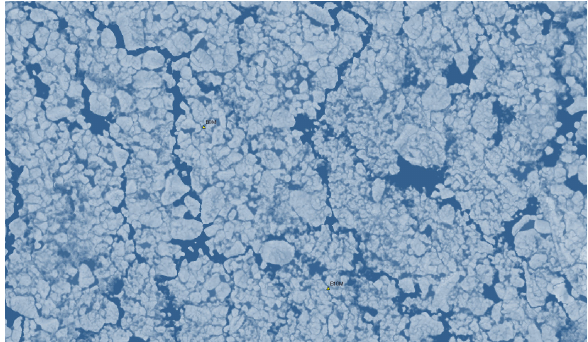
Figure 7: Topographic wetness index derived from the high- resolution digital elevation model.